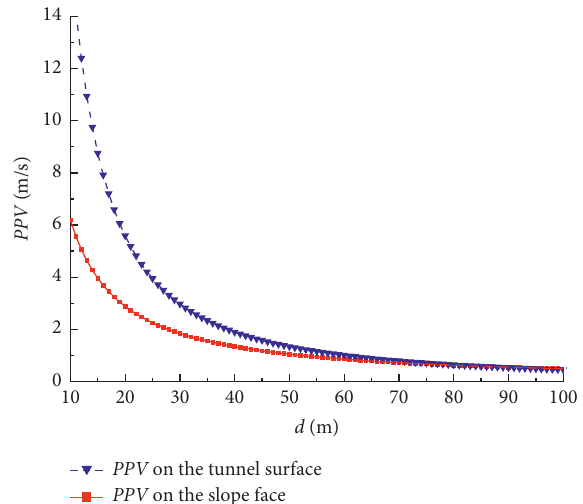
Figure 7: Vector PPV attenuation with distance at the charge weight of 24